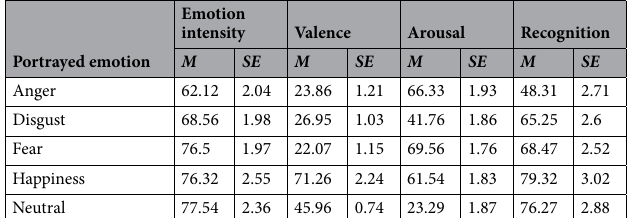
Portrayed emotion